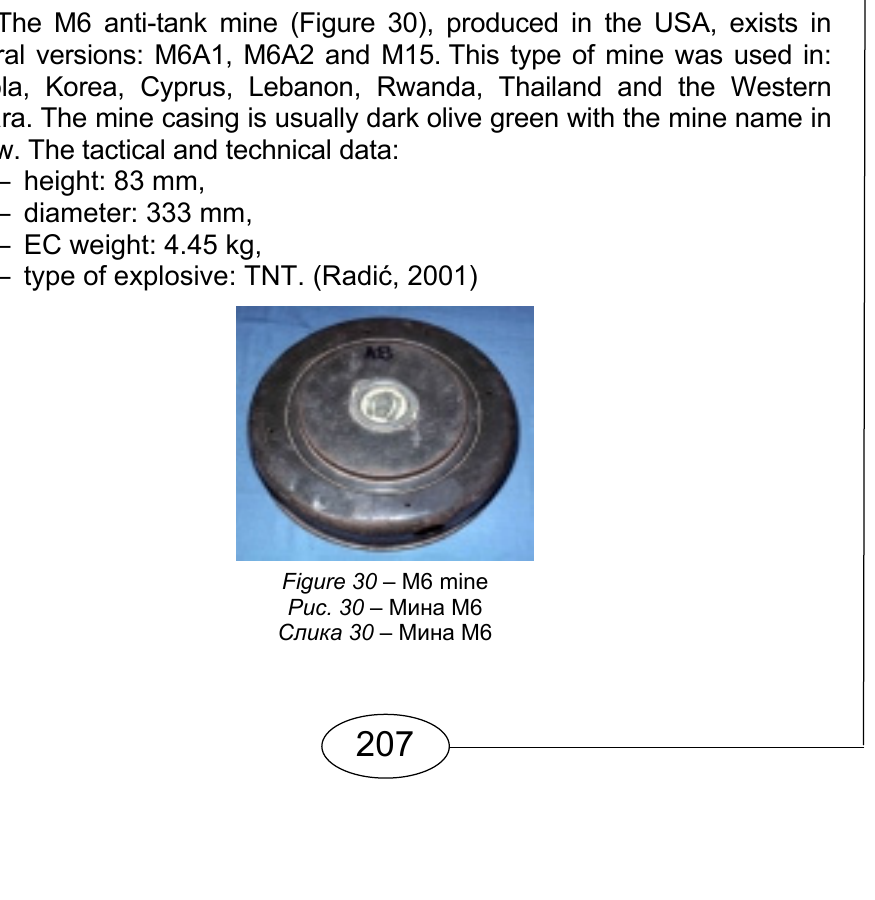
Figure 29 – M19 mine Рис . 29 – Мина М 19 Слика 29 – Мина M19